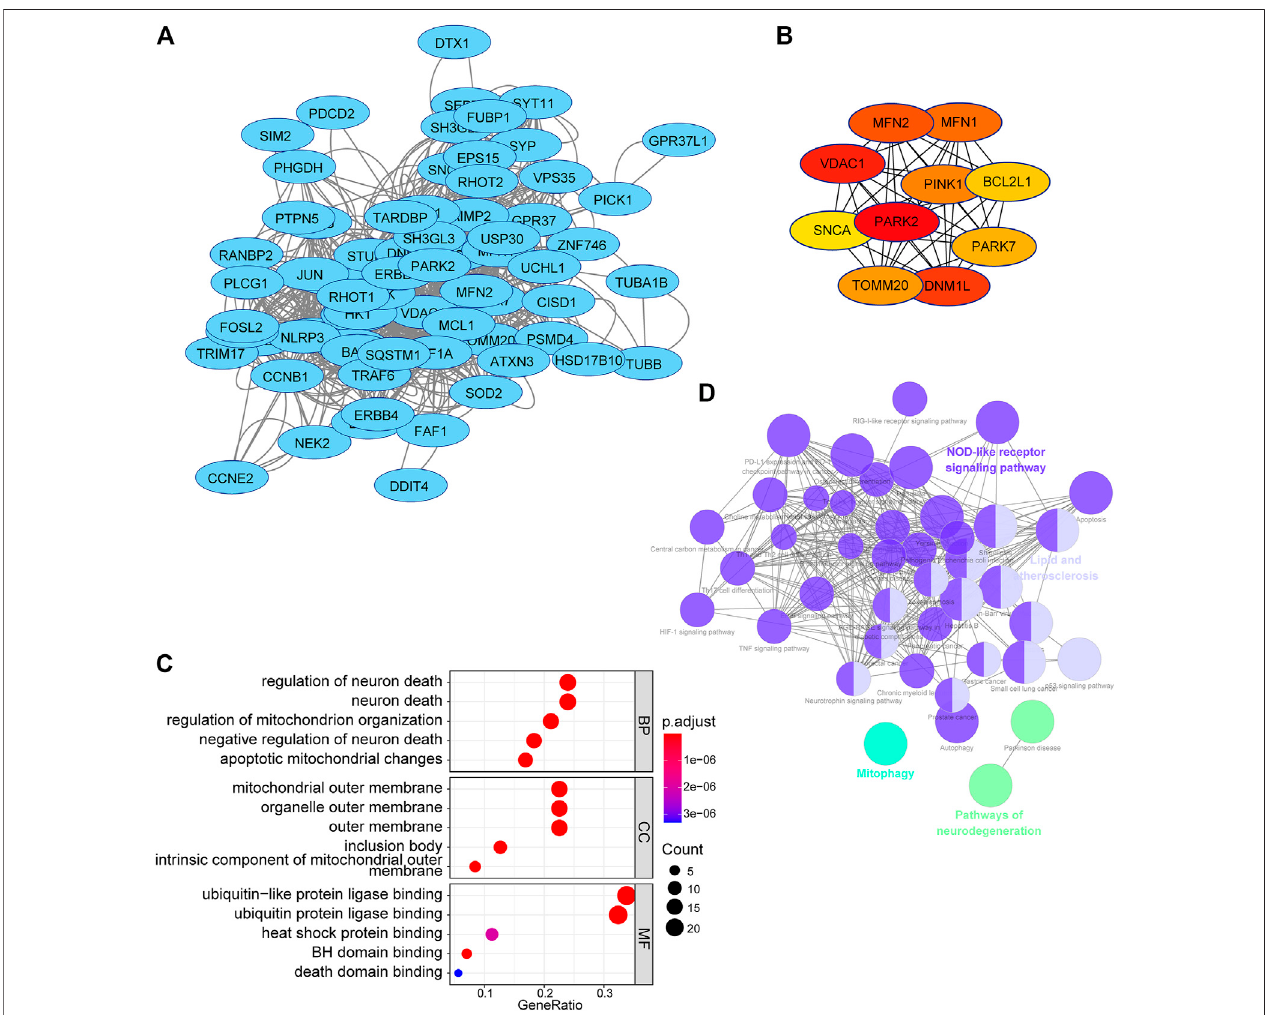
FIGURE 11 | PPI network and functional analysis of substrates of the E3RG signature in LGG. (A) PPI network of substrates of the E3RG signature obtained with interaction scores > 0.4 based on the STRING online database and visualized using Cytoscape. (B) Top 10 hub genes identi fi ed using the MCC algorithm of the cytoHubba plugin in Cytoscape. (C) GO analysis of substrates of the E3RG signature with three terms biological processes, cellular components, and molecular functions (P.adjust < 0.05). (D) KEGG pathways enriched in the substrates of the E3RG signature analyzed using ClueGO plugin in Cytoscape ( p <